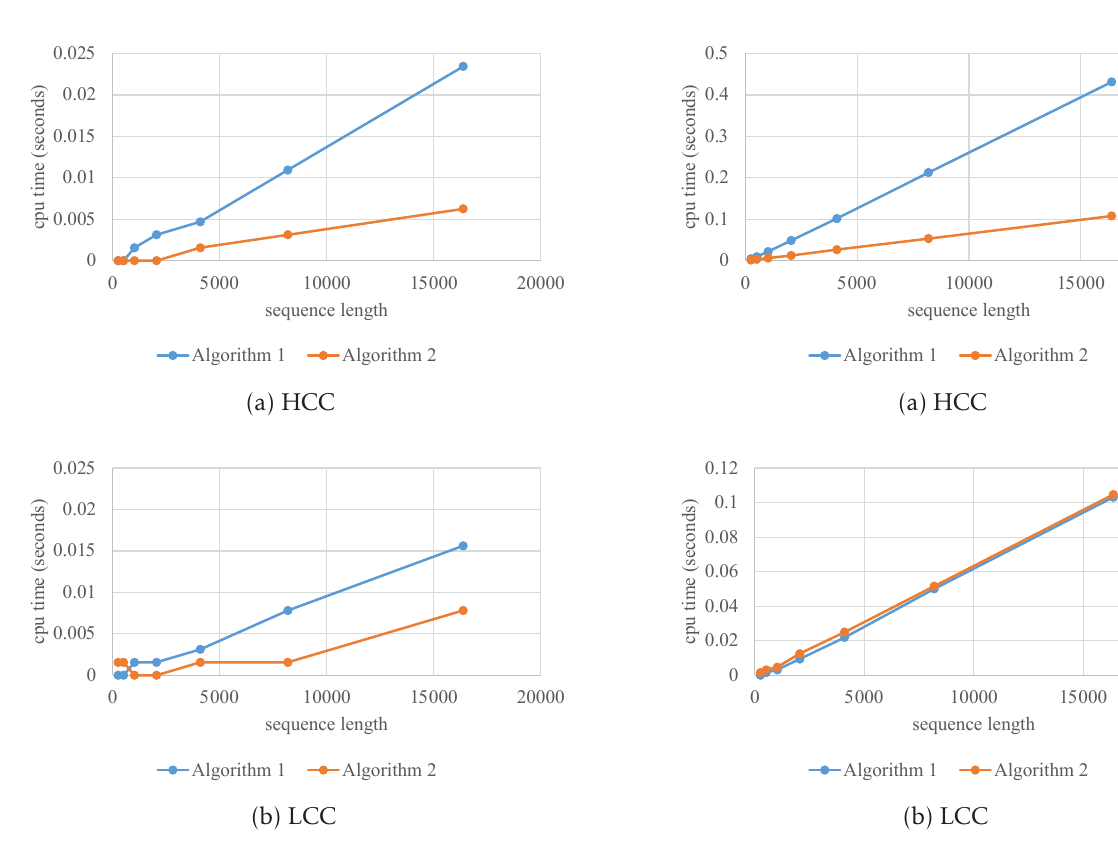
Figure 6. Average CPU time for sequences of 32 character long String objects.